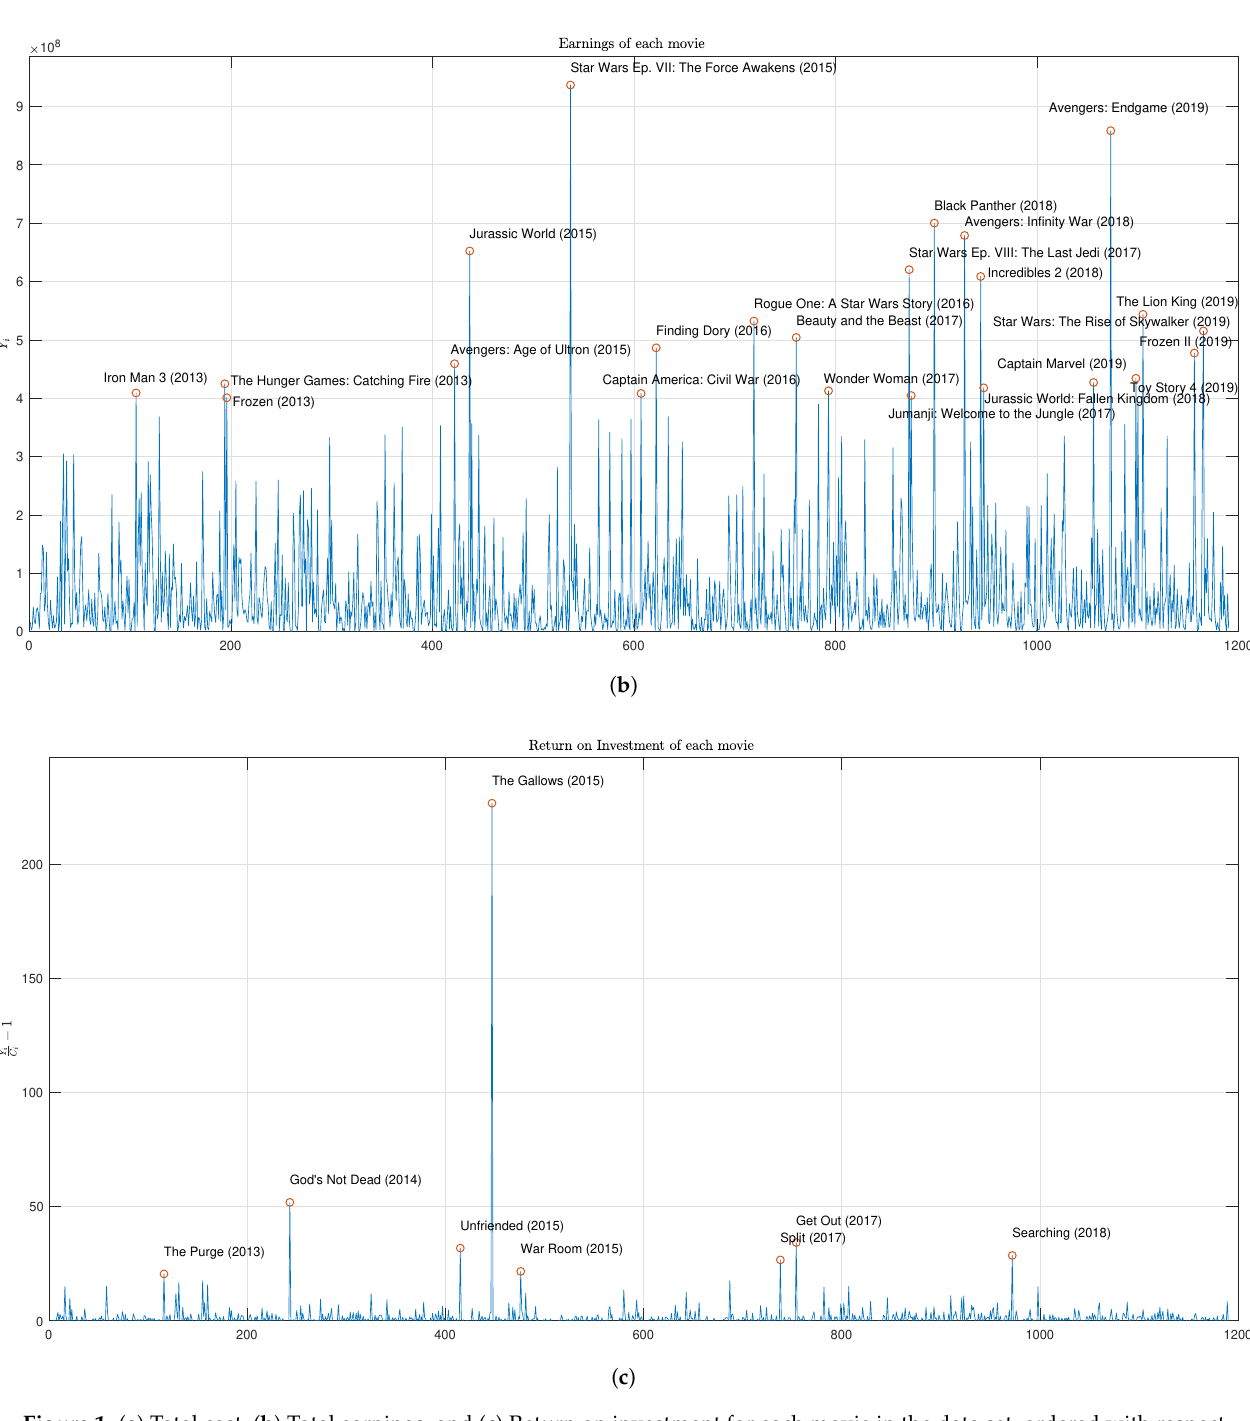
Figure 1. ( a ) Total cost, ( b ) Total earnings, and ( c ) Return on investment for each movie in the data set, ordered with respect to the date of